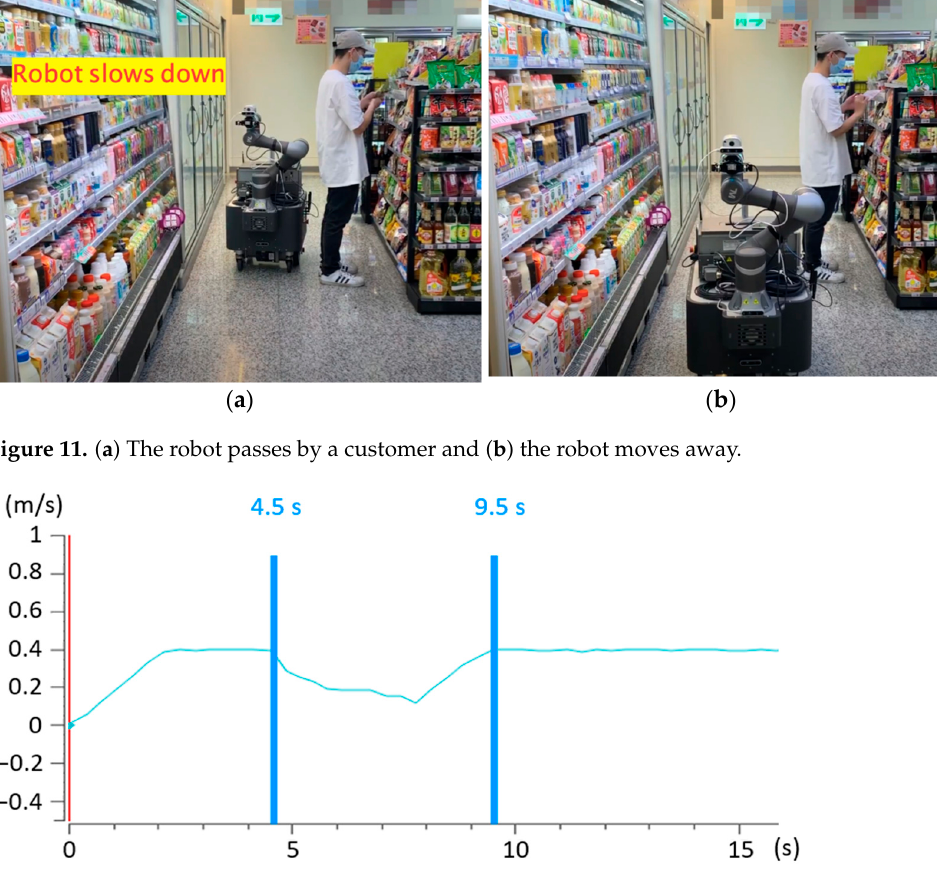
Figure 12. Speed adjustment during path navigation.